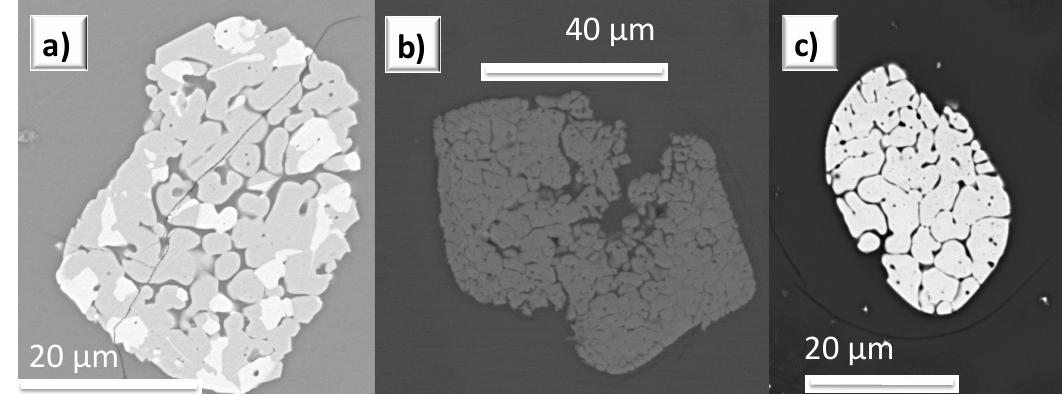
Figure 13. SEM back-scattered images of granular titanomagnetite in: ( a ) El’gygytgyn glass after [38]. Note that the darker phase is TiO 2 -rich; ( b ) irghizite from [12]; ( c ) Pantasma glass from [11].